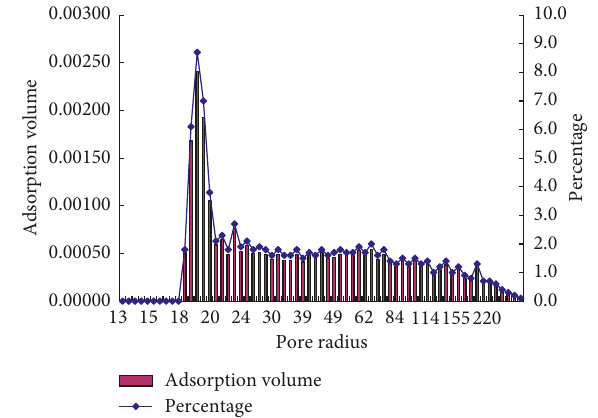
Figure 5: Line chart of pore radius and adsorption volume per- centage (without modifier added).